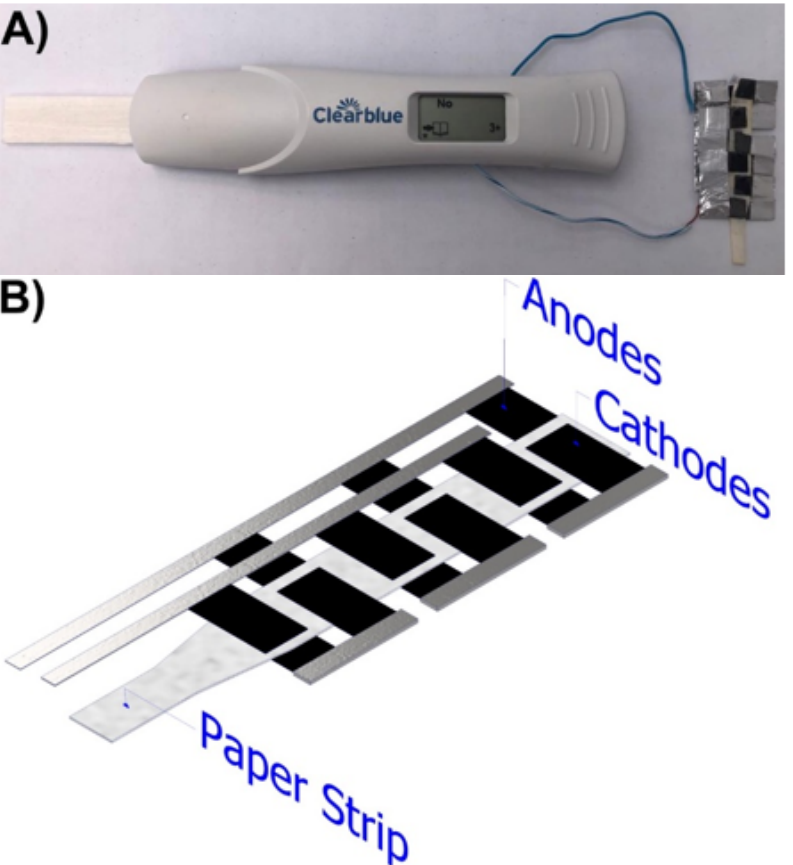
Figure 2. ( A ) Air-breathing paper-based microfluidic fuel cell stack (6-cell series/parallel arrange- ment) using urine as fuel and air as oxidant placed outside the quantitative pregnancy test. ( B ) Scheme of the series/parallel arrangement of the paper-based microfluidic fuel cell